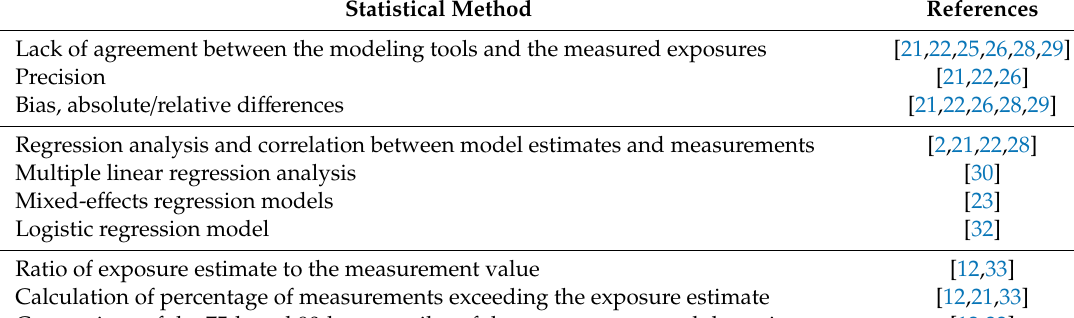
Table 2. Summary of statistical methods used by di ff erent authors. Statistical